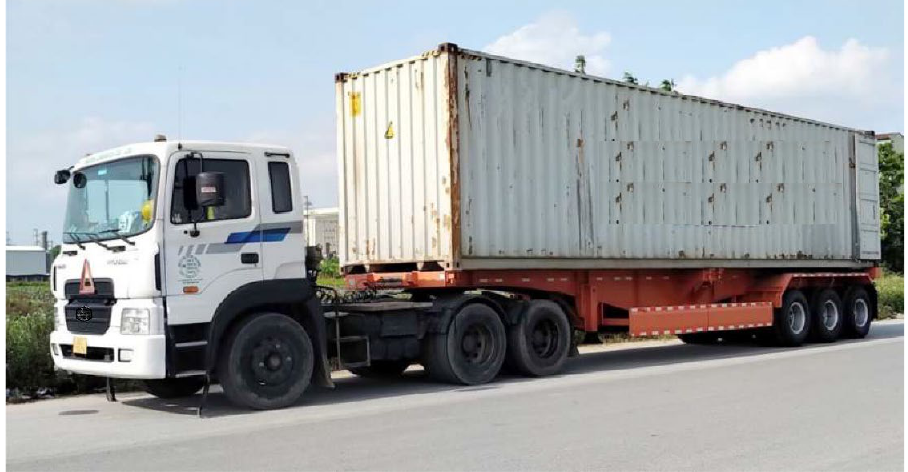
Figure 5. Tractor semi-trailer used in the experiment .